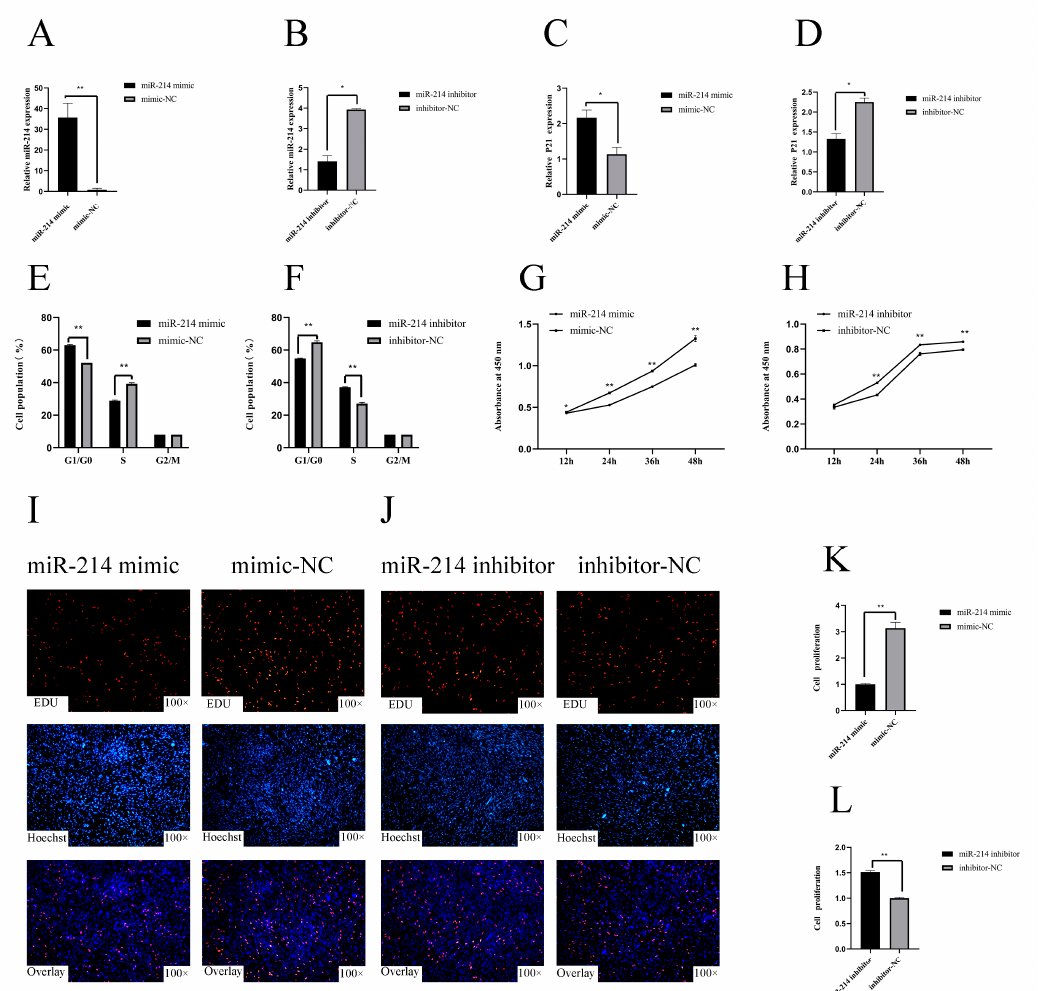
Figure 1. miR-214 inhibits the proliferation of chicken myoblasts. ( A , B ) The relative mRNA expression of miR-214 after transfection with the miR-214 mimic and inhibitor in chicken primary myoblasts (CPMs). ( C , D ) The relative mRNA expression of p21 after transfection with the miR-214 mimic and inhibitor in CPMs. ( E , F ) Cell cycle analysis of the CPMs 48 h after the overexpression and inhibition of miR-214 using propidium iodide staining for DNA content. ( G , H ) Cell growth was measured following transfection of the miR-214 mimic and inhibitor in CPMs. ( I , J ) After miR-214 overexpression and interference, EdU detected the proliferation of CPMs. ( K , L ) Proliferation rates of CPMs with miR-214 overexpression and inhibition. * p < 0.05 and ** p < 0.01.